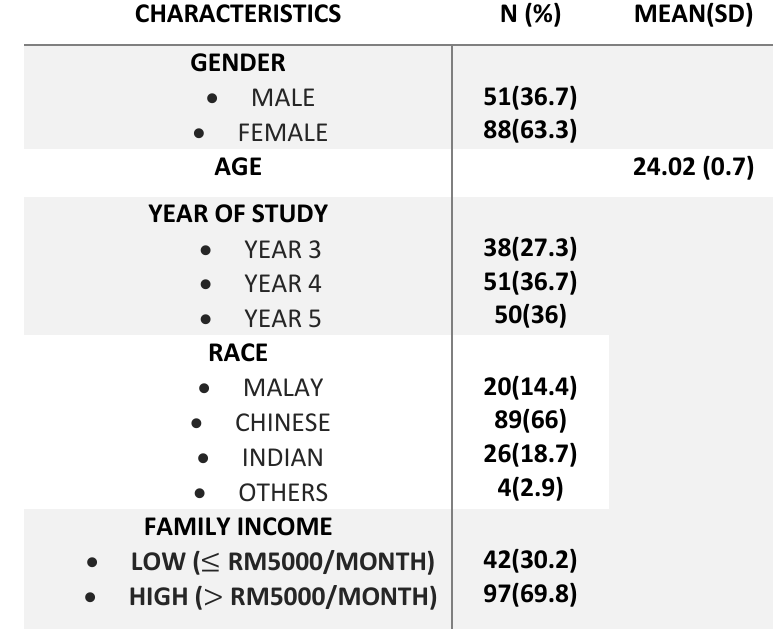
Table 1. Background characteristics of the participants ( ¥ n = 140,